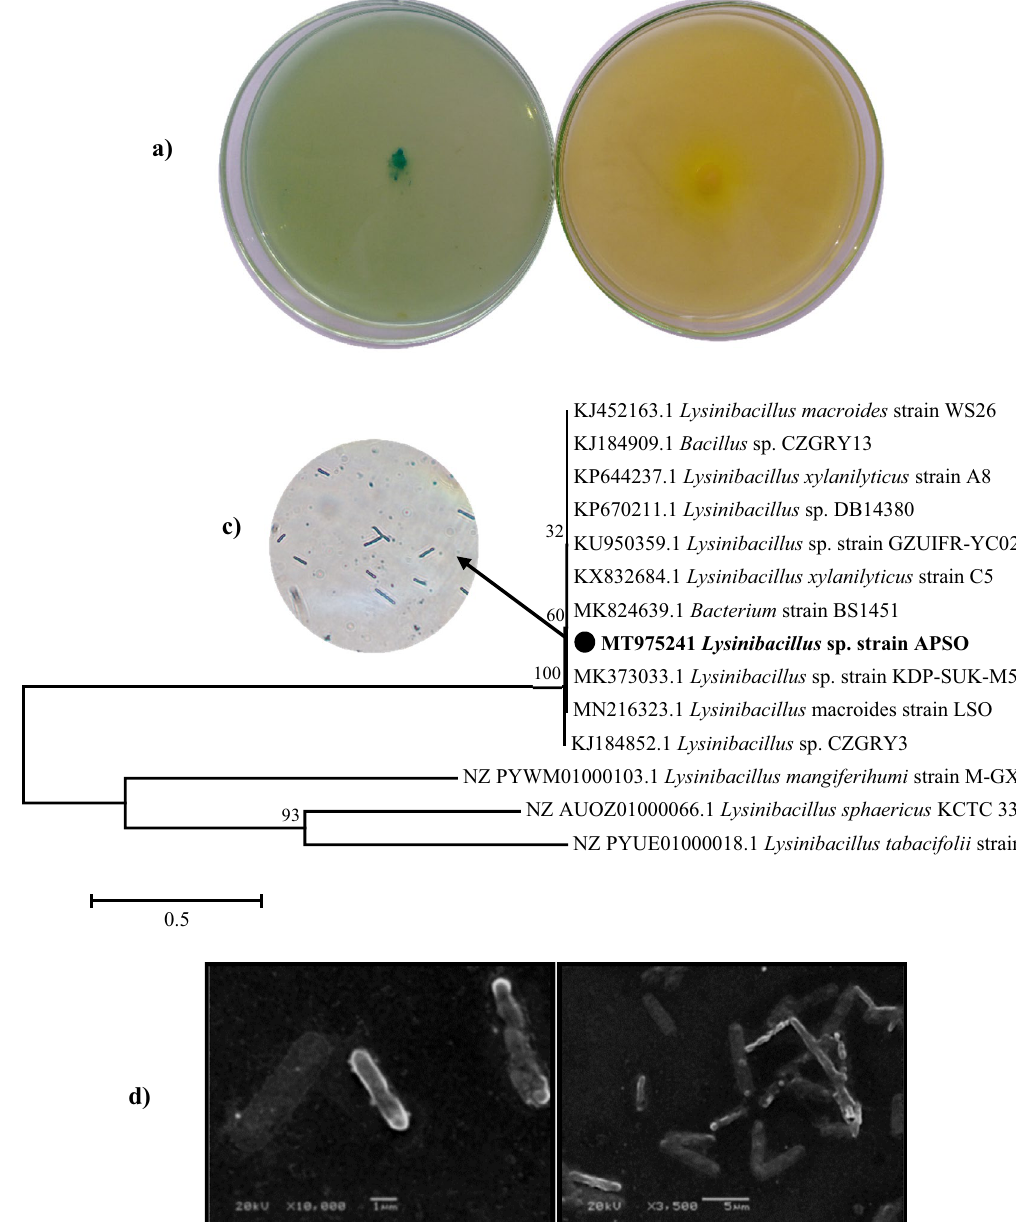
Figure 2. Isolation, screening, and identification of ALP-producing bacteria. (a) Qualitative screening of ALP- producing bacteria. (b) Phylogenetic tree based on 16S rDNA gene sequence analysis showing the relationship of Lysinibacillus sp. strain APSO with reference strains (NCBI GenBank) constructed using the neighbor-joining method with the aid of MEGA 7.0 program. Sequence divergence is indicated by the scale bar. (c) Gram stain of Lysinibacillus sp. strain APSO (magnification, oil lens, × 100). (d) SEM micrograph of Lysinibacillus sp. strain APSO showing cell morphology at a magnification of × 3500 and × 1000 with 20